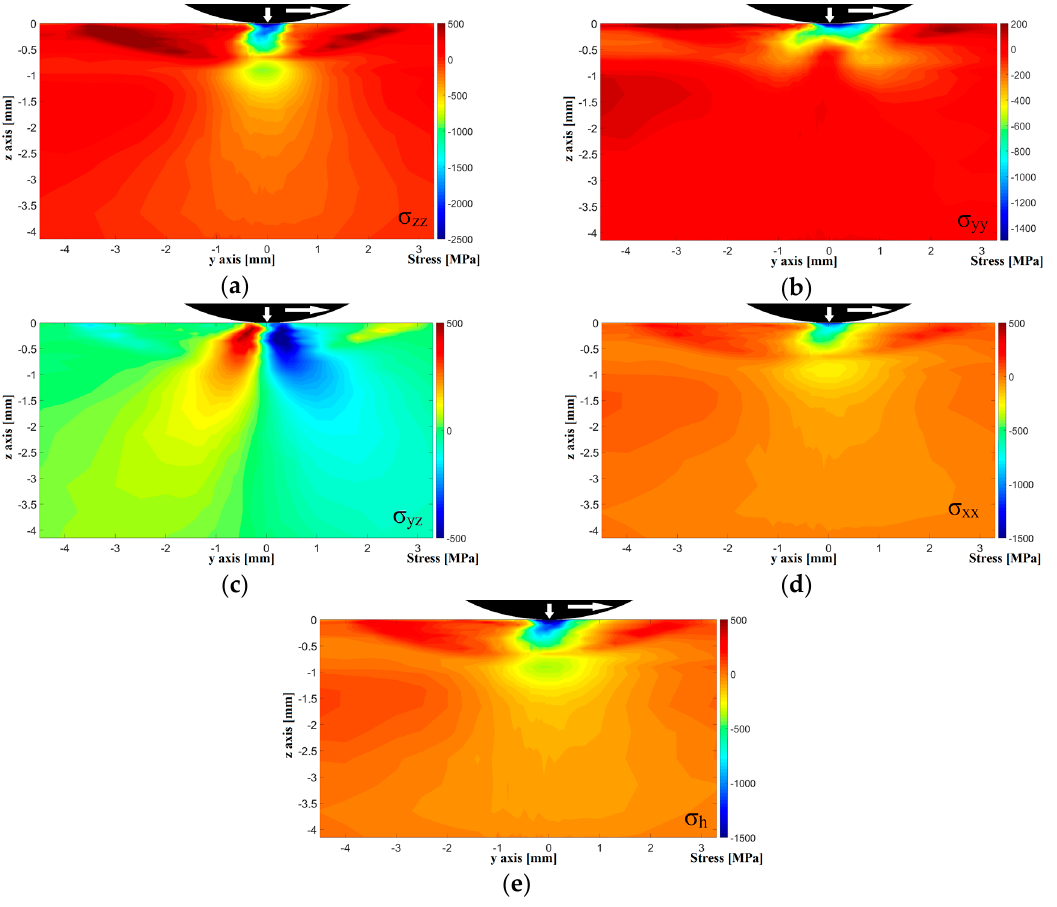
Figure 3. ( a )Stress distribution of σ zz component; ( b ) σ yy component; ( c ) σ yz component; ( d ) σ xx component; ( e ) and hydrostatic σ h component for 3900 N contact force.